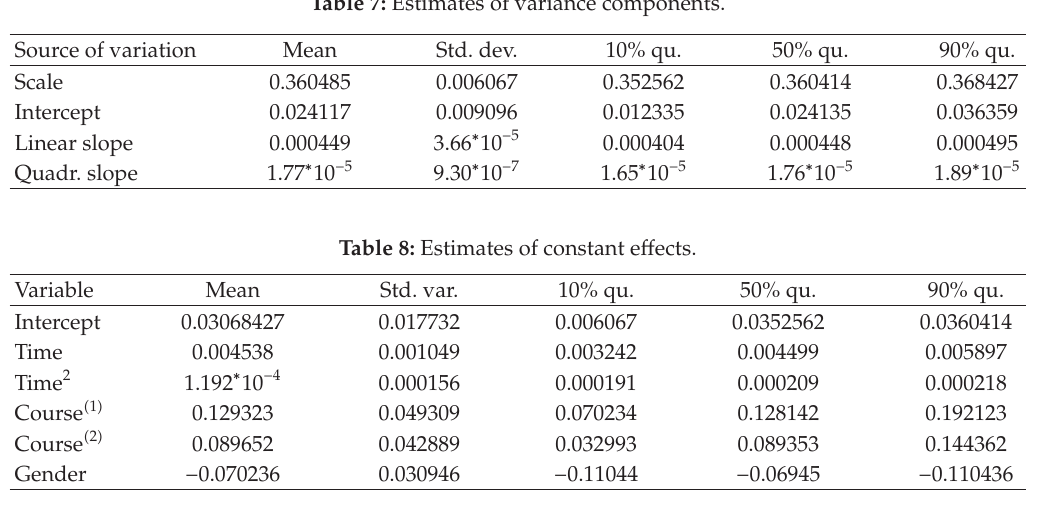
Table 7: Estimates of variance components.